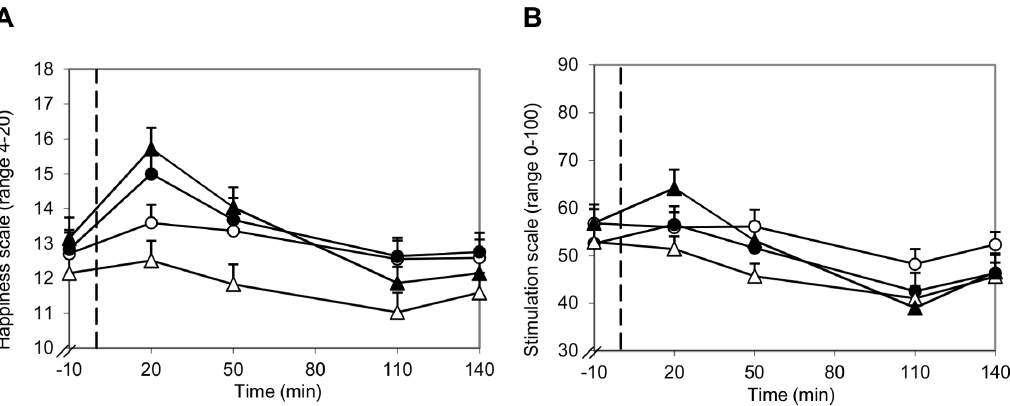
N Figure 3. Influence of ambiance and alcohol on POMS happiness scores (A) and B-BAES stimulation scores (B). 2 # 2 Pleasant, 2 Pleasant, alcohol; 2 D 2 Unpleasant, alcohol-free; 2 m 2 Unpleasant, alcohol; - - start alcohol consumption (t=0). ( A ) Happiness alcohol-free; 2 scores were higher 20 min and 50 min after alcohol consumption compared to no alcohol consumption ( P , 0.001 and P , 0.05, respectively). Happiness scores were lower in the unpleasant ambiance without alcohol than in the pleasant and unpleasant ambiance with alcohol ( P , 0.001) and in the pleasant ambiance without alcohol ( P , 0.05). ( B ) Stimulation scores were decreased from 20 min until 50 min after alcohol consumption, which did not occur after consumption of alcohol-free drinks ( P , 0.05 vs. P =1.0). Stimulation scores tended to be higher in the pleasant ambiance without alcohol than in the unpleasant ambiance without alcohol ( P =0.08).